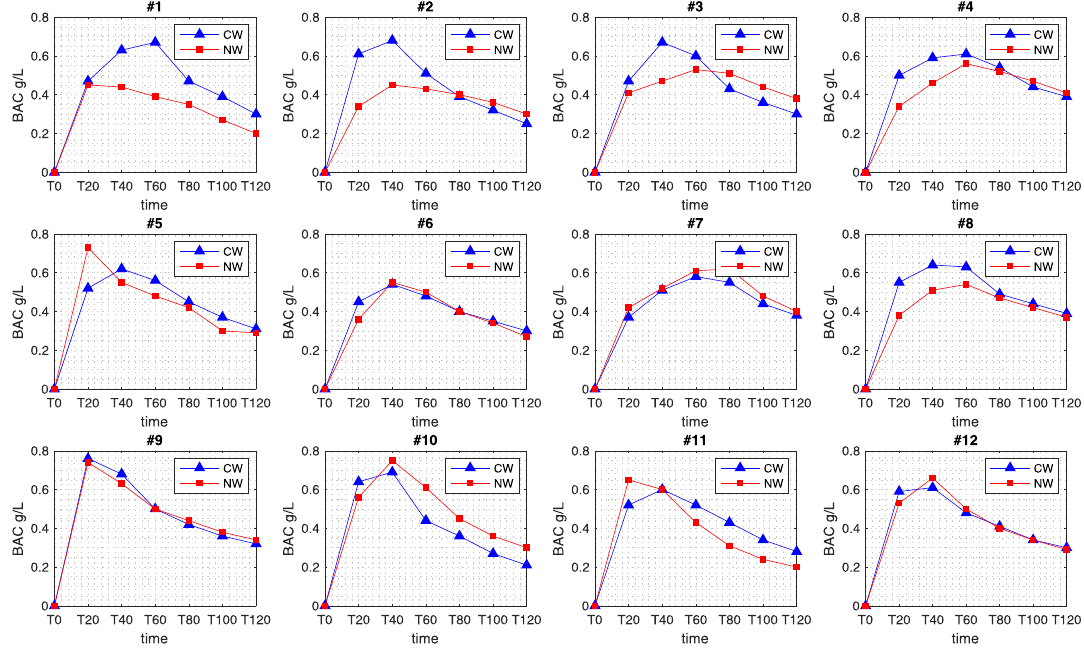
Figure A1. Concentration–time curves of BAC responses to natural wine and conventional wine for subjects #1 – #12.